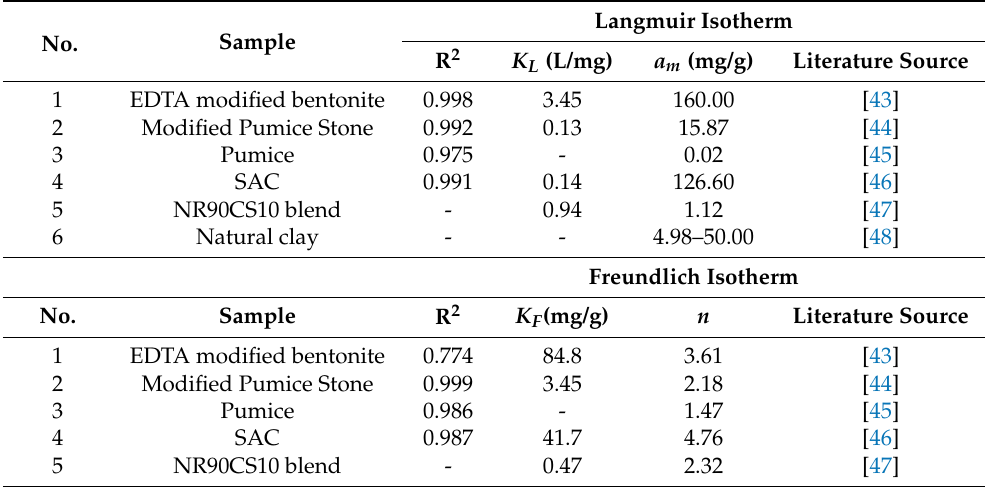
Table 5. Isotherm parameters for adsorption of MB from water solutions for selected adsorbents based on the literature